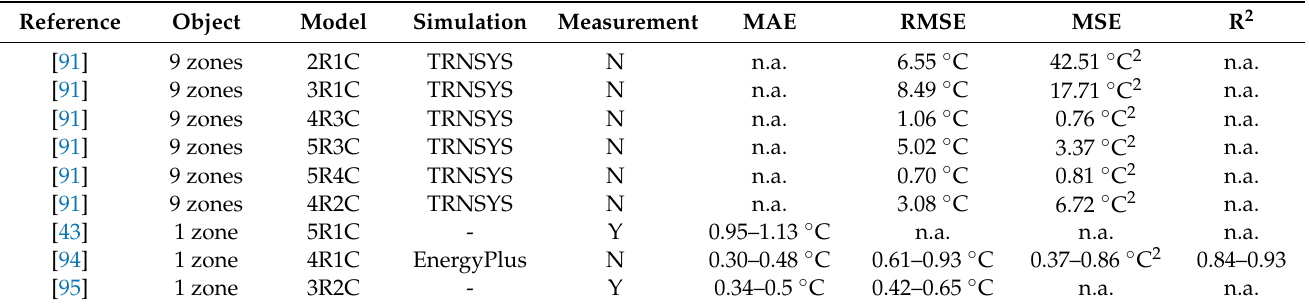
Table 4. Simulations of buildings with the use of thermal network models with error analyses of indoor air